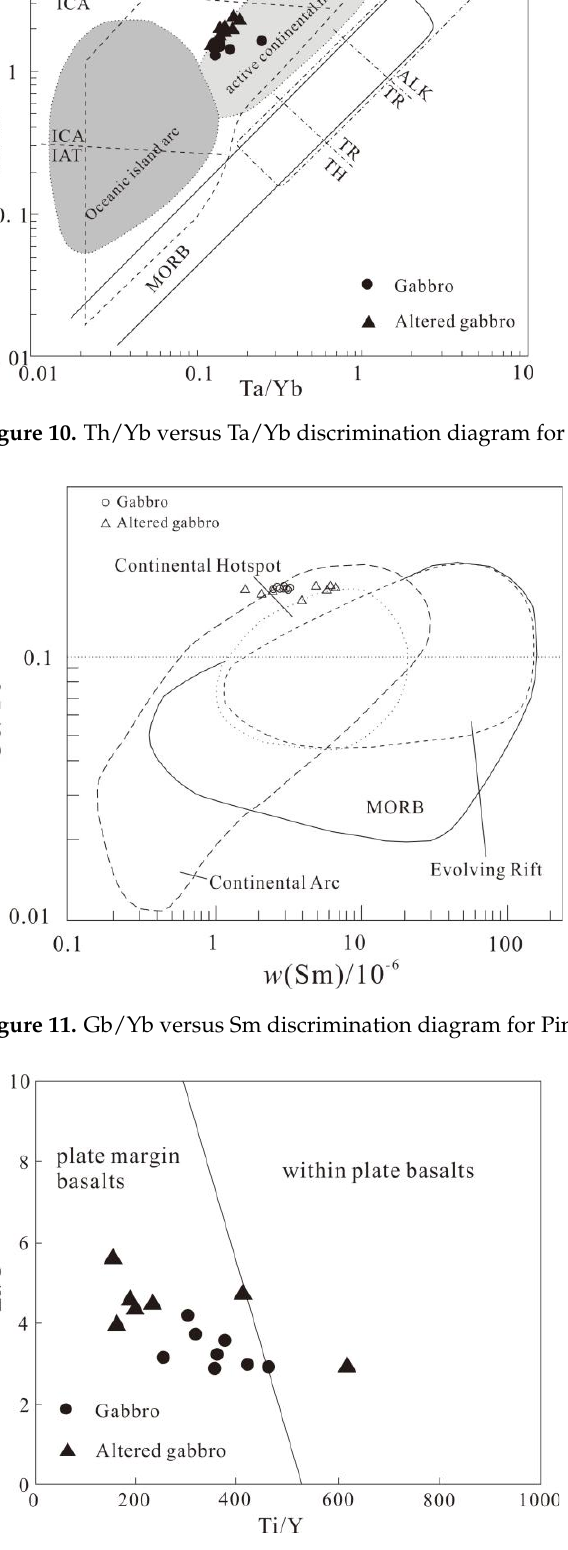
Figure 12. Zr/Y versus Ti/Y discrimination diagram for Ping’an gabbros.